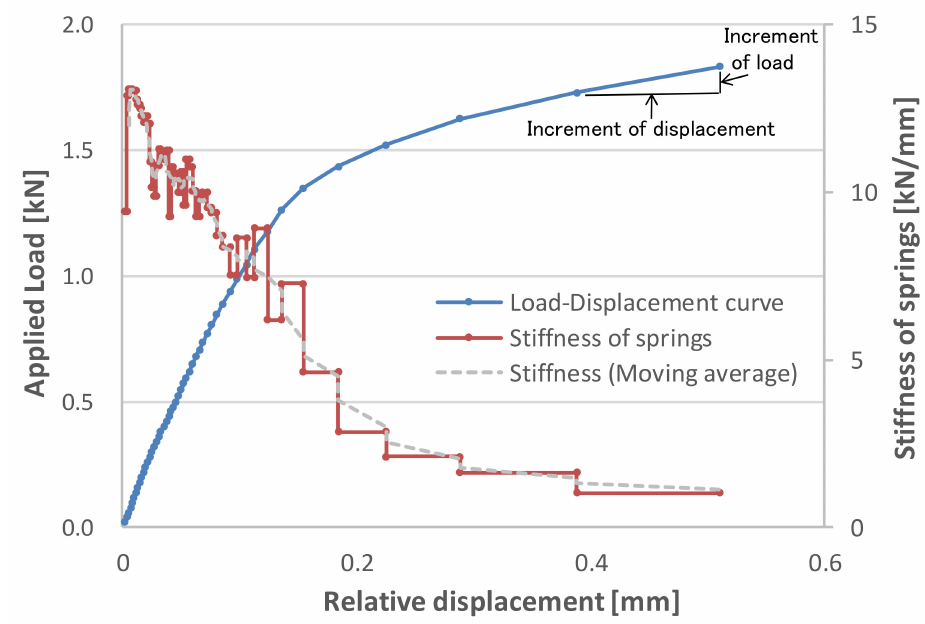
Figure 16. Derivation of stiffness of nonlinear springs in the simplified